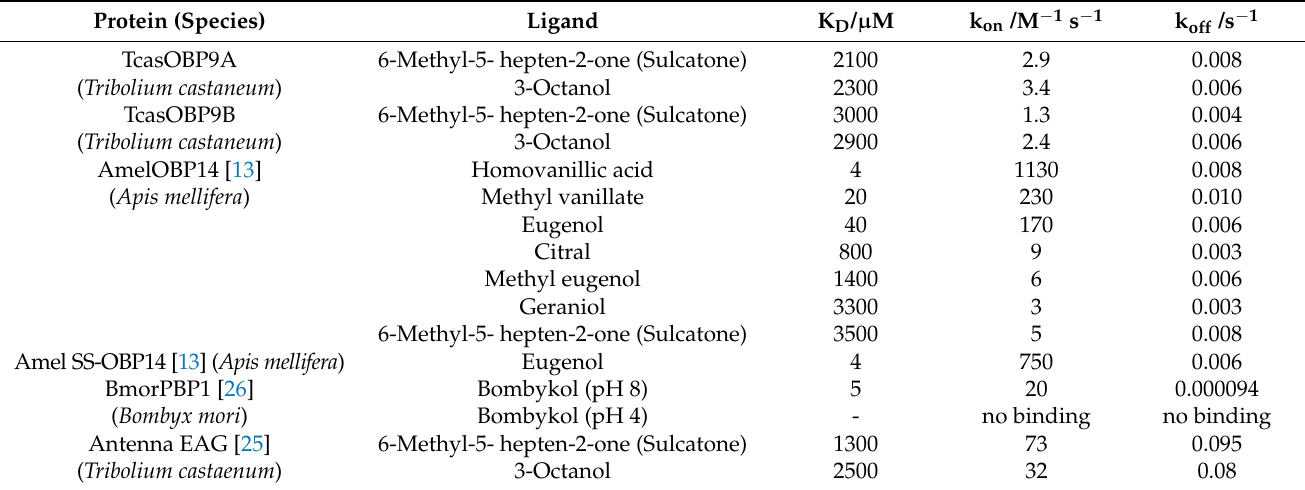
Table 1. Odorant-binding kinetics of